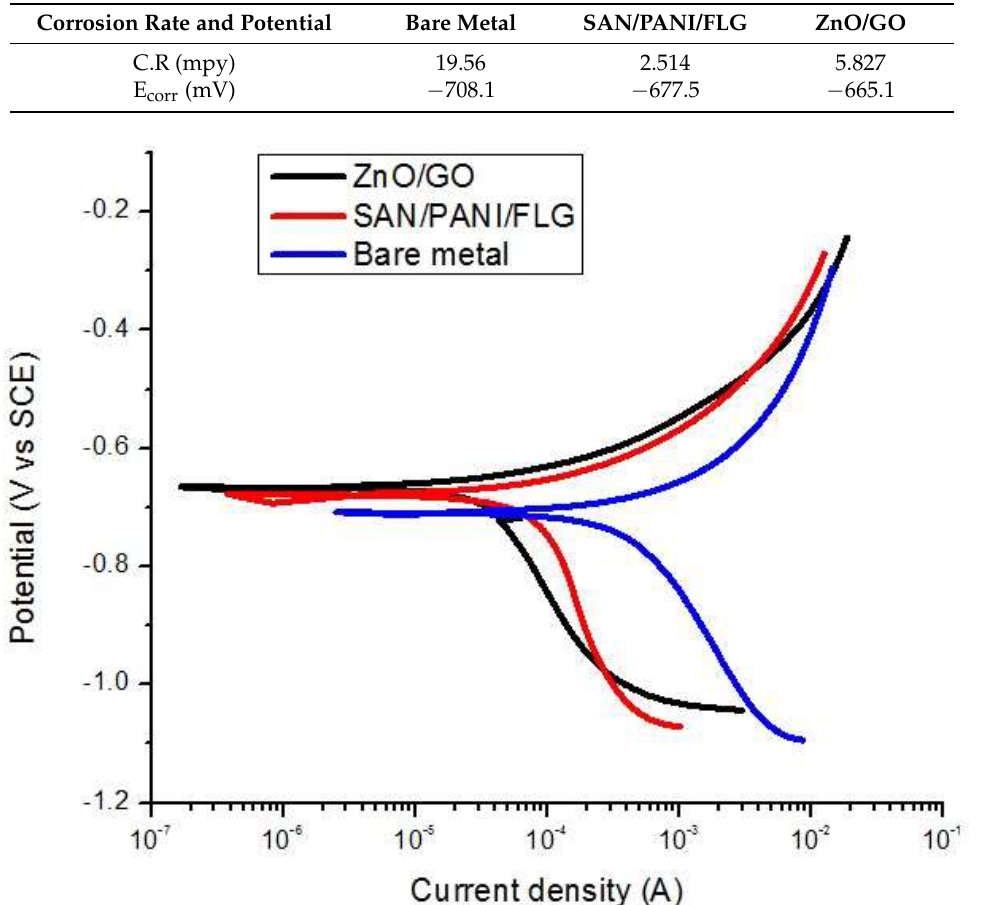
Figure 4. ’E-log i’ curves-bare and coated samples in seawater. Table 6. Corrosion rate (C.R) data from Tafel scan.